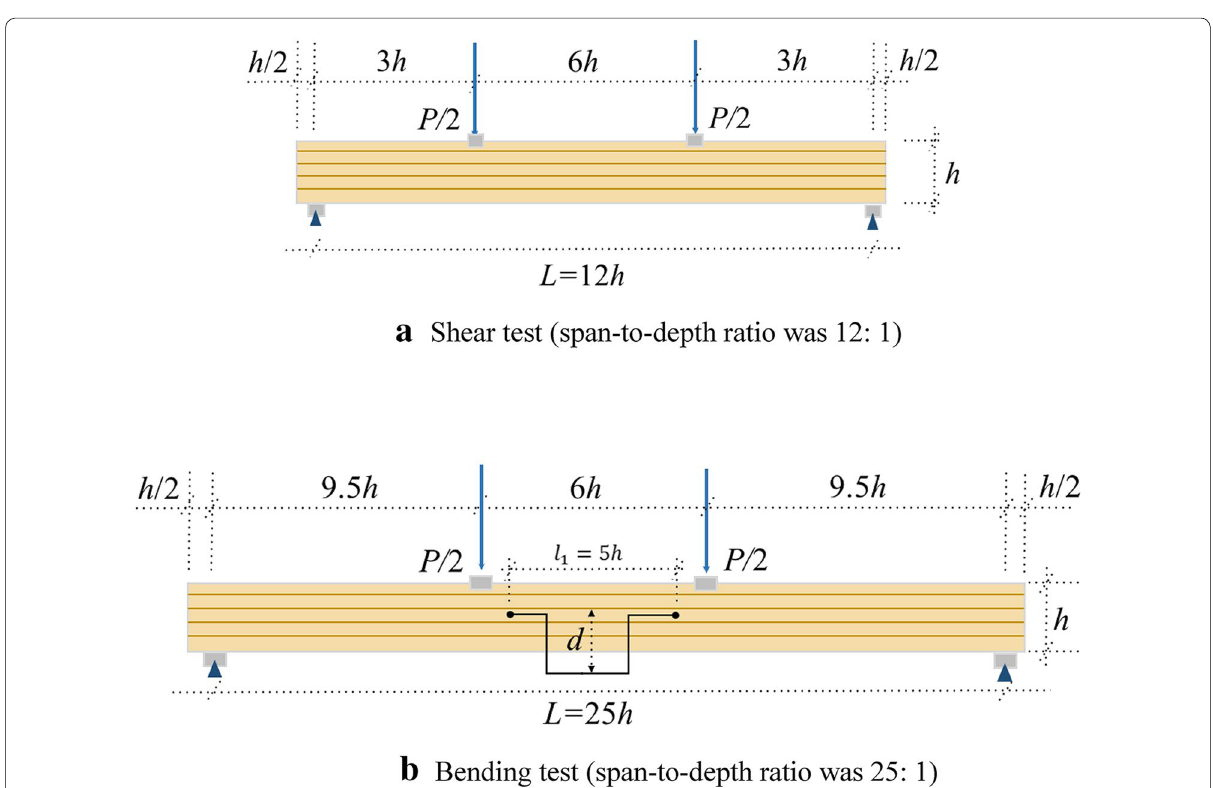
Fig. 2 Test configuration for measuring shear and bending properties. h thickness of specimen (mm), P load (N), L span of specimen